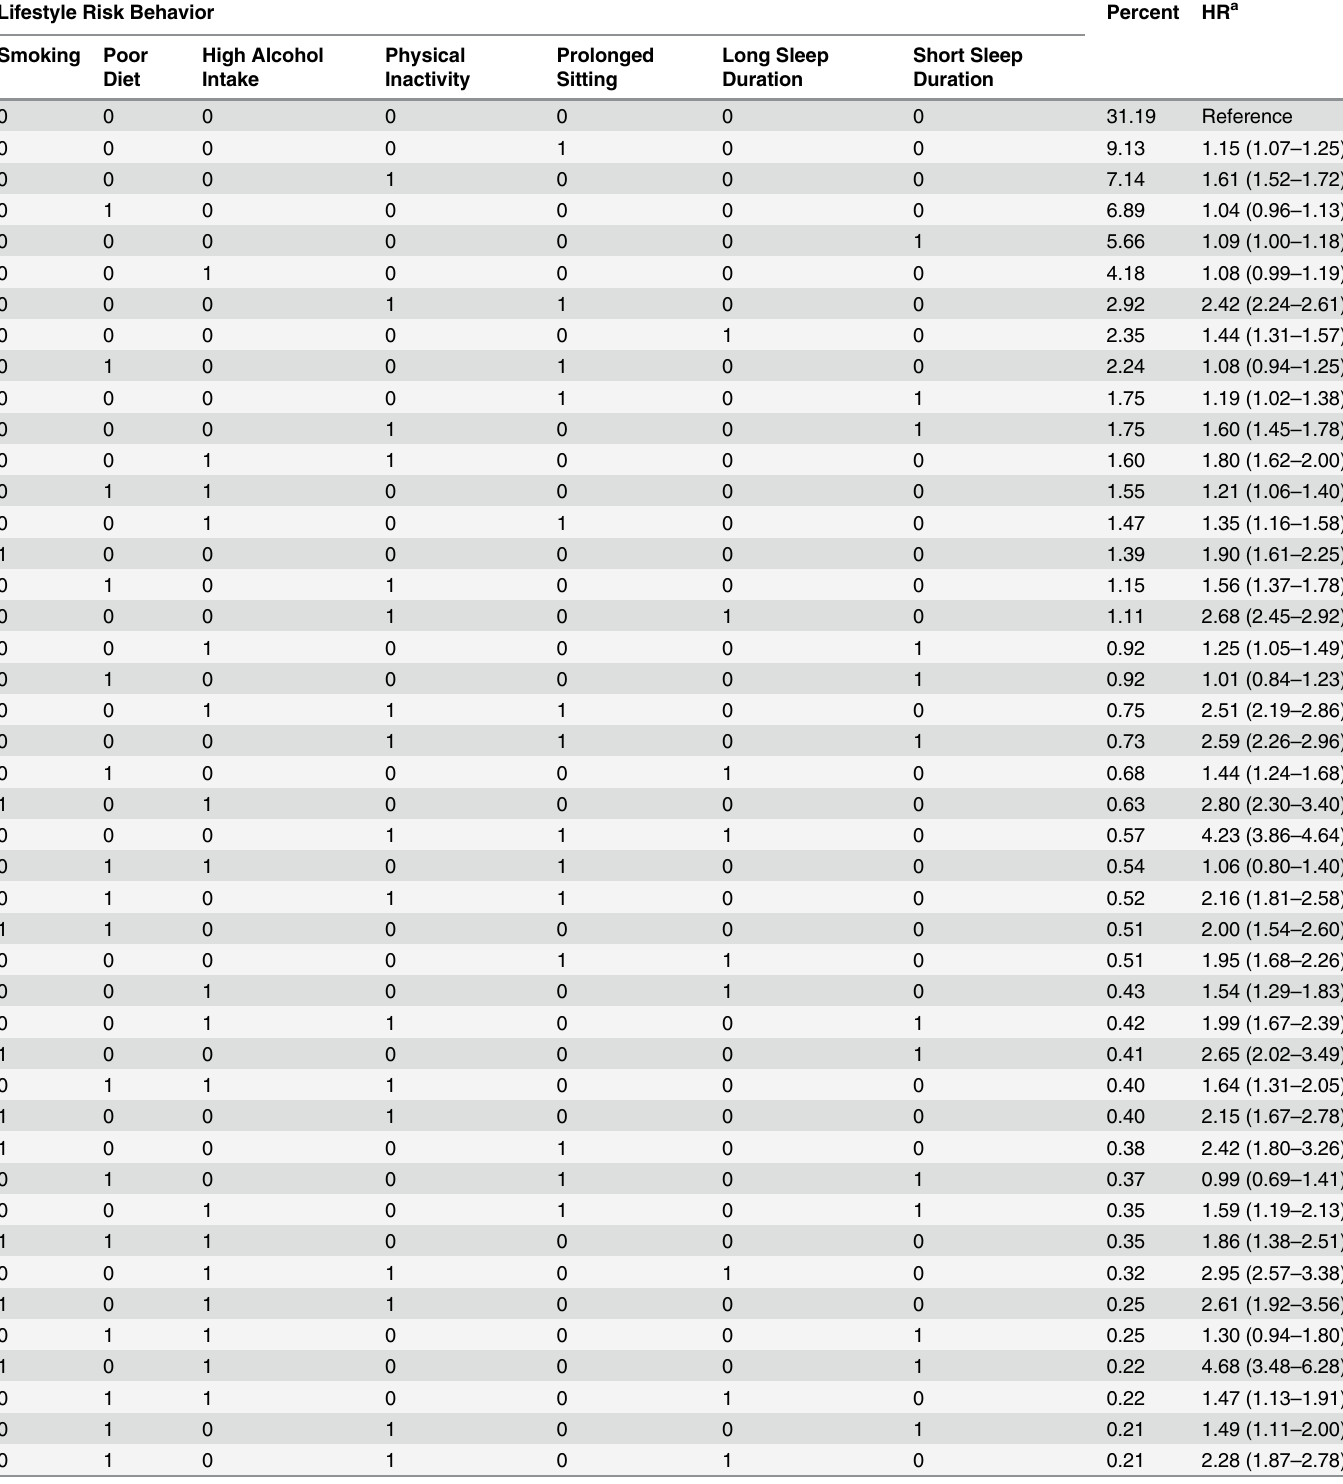
Table 4. Prevalence of all 96 combinations of lifestyle risk behaviors and adjusted hazard ratios for their associations with all-cause mortality among middle-aged and older adults based on the 45 and Up Study, Australia (2006 – 2014, n =